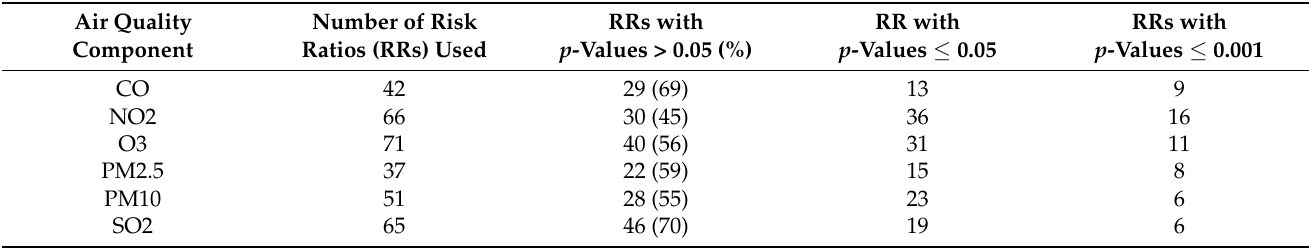
Table 6. Summary information about numbers of base papers and significant results used for meta-analysis for each air quality